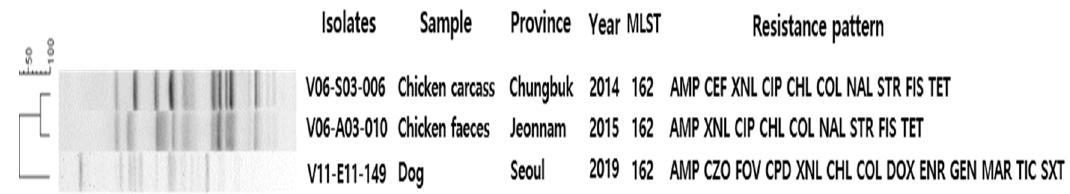
Figure 1. Xbal -digested pulsed-field gel electrophoresis patterns of mcr - 1 -carrying E. coli strains isolated from a diarrheic dog and chickens in Korea. AMP, ampicillin; CPD, cefpodoxime; CEF, cephalothin; CHL; chloramphenicol; CIP, ciprofloxacin; COL, colistin; CZO, cefazolin; DOX, doxycycline; ENR, enrofloxacin; FIS, sulfisoxazole; FOV, cefovecin; GEN, gentamicin; MAR, marbofloxacin; NAL, nalidixic acid; STR, streptomycin; SXT, trimethoprim / sulfamethoxazole; TET, tetracycline; TIC, ticarcillin; XNL, ceftiofur.